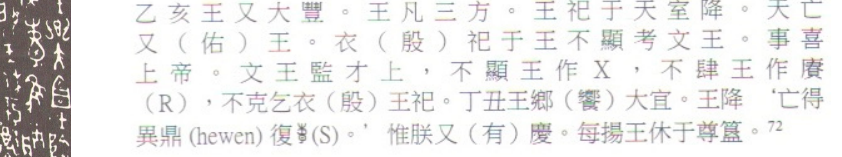
Figure 1. Masked semi-human figures with arms raised. ( A ) Yi 異 graph; ( B ) Displayed yi image, probably Kui; ( C ) Simplified displayed yi image. The significance of these yi or metamorphic power images is directly allied with the king’s Figure 7. Tian Wang gui inscription and translation (right) and a detail showing the use of “ 得 ( 得 異鼎 ) 復 (“ de yiding fu ?)” or “obtaining the yiding and restoring [the royal] title (?))” on the cosmological power to rule, as revealed in a related term, yiding ( 異鼎 ), the hewen (two graphs joined into one graph) known in a variety of early inscriptional contexts including Shang and pre- conquest Western Zhou divinatory inscriptions and Western Zhou bronze vessel inscriptions. As will be analyzed below, these inscriptional contexts corroborate that yiding refers specifically to the tetrapod fangding, and secondly to a fangding with yi spirit power, the basis of a king’s power to rule in Shang time and apparently also in Western Zhou time. The types of data that exhibit a continuation of Shang belief in these symbolic attributes are both archaeological and paleographic, depending on extant or excavated fangding and their inscriptions. As will become clear, royal fangding and yiding were one and the same vessel.